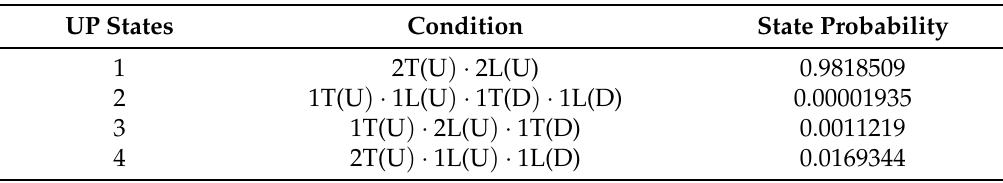
Table 4. State probabilities for the operable (UP) states.